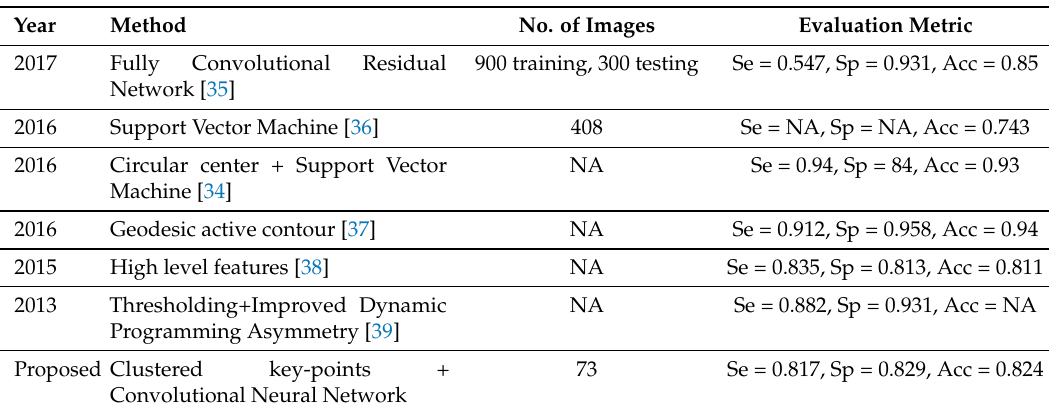
Table 3. Comparison of results to other